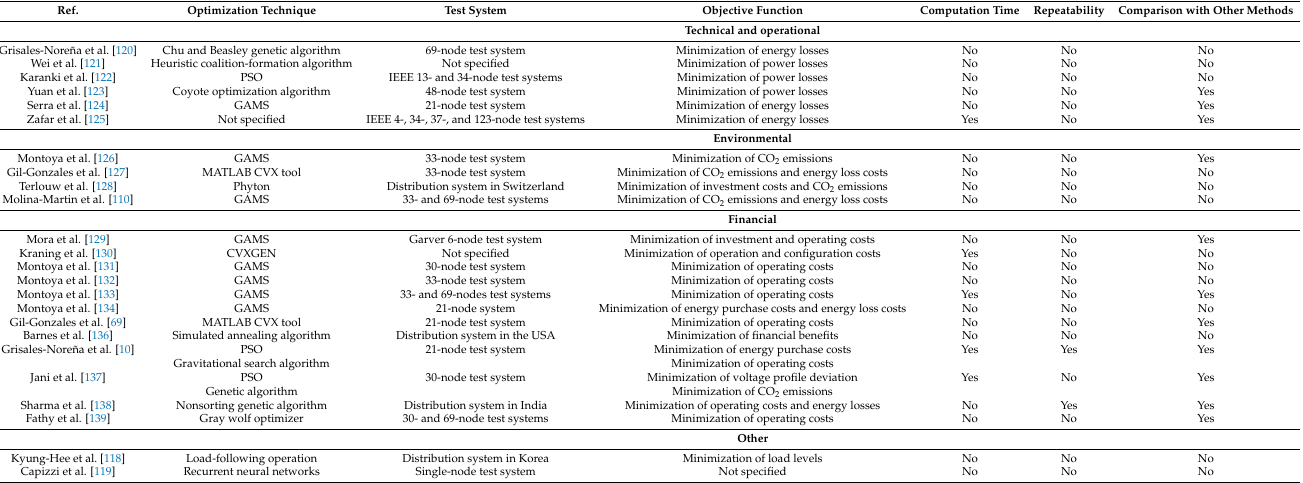
Table 2. Methodologies for the optimal location and sizing of energy storage